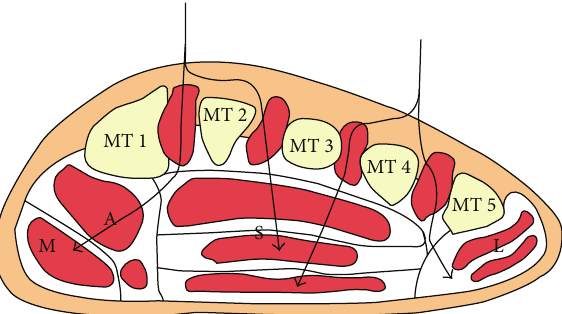
Figure 8: Dynamic wound closure using the vessel loop or shoelace